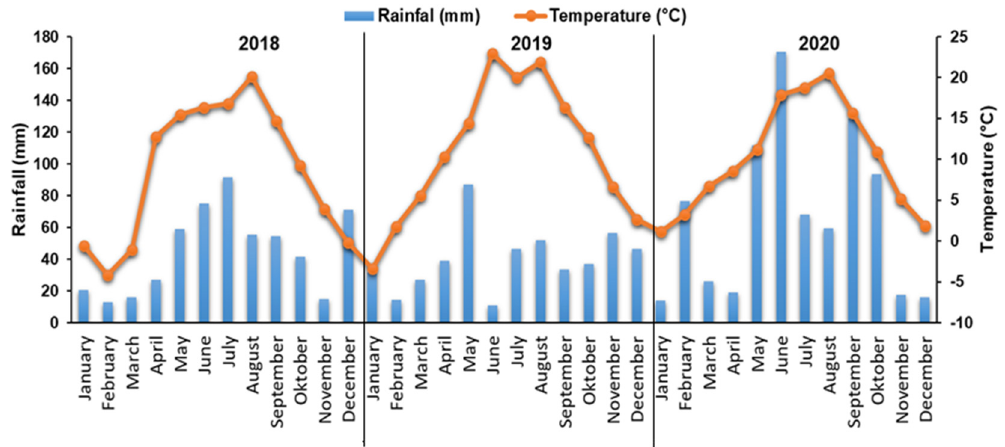
Figure 2. Mean monthly temperatures and rainfall in the experimental site during the experimental period.